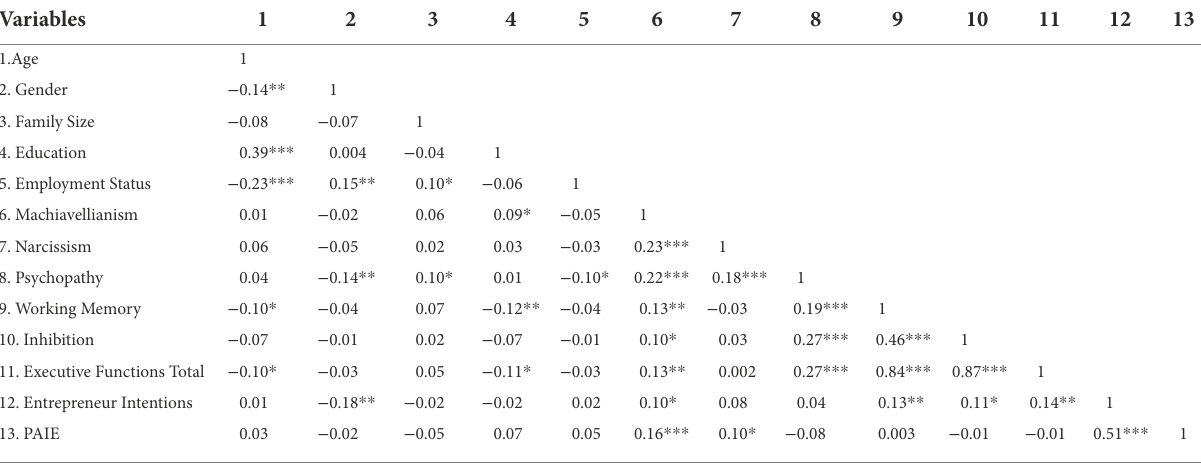
TABLE 5 Inter-correlation among demographics and study variables (Dart personality traits, Executive functioning (Working memory, Inhibition), Entrepreneur intentions, and Perceived academic intent to entrepreneurship).